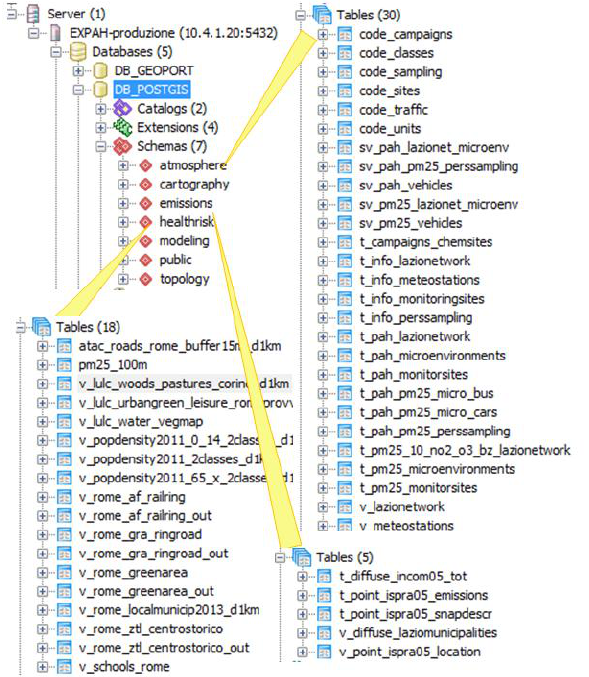
Figure 2. Organization of the PostgreSQL/PostGIS